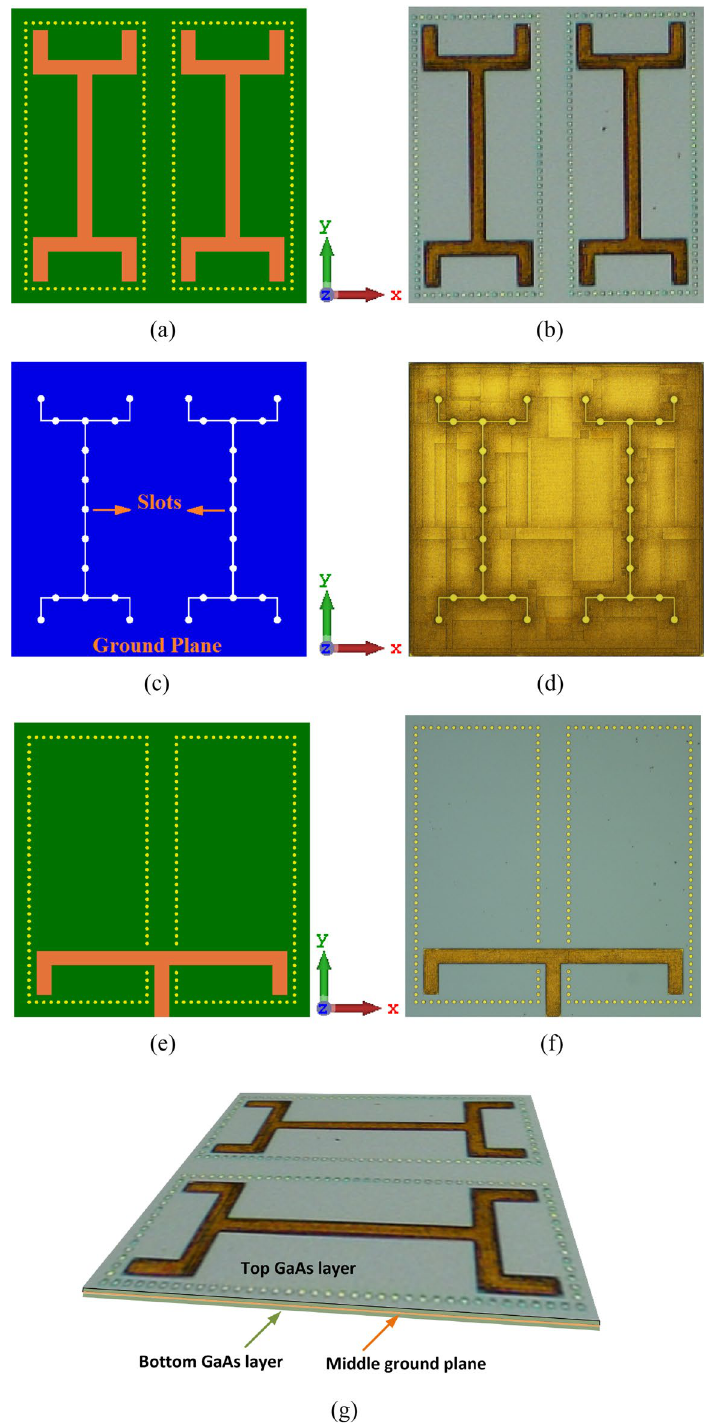
Figure 1. Layout of the SIW inspired on-chip antenna, ( a ) simulated configuration and ( b ) fabricated prototype of the GaAs antenna showing the top surface of the top GaAs layer; ( c ) simulated layout and ( d ) fabricated prototype of the middle metallic ground-plane with circular and linear slots. This layer is sandwiched between the top ( b ) and bottom ( f ) GaAs layers; ( e ) simulated configuration; ( f ) fabricated prototype of the GaAs antenna showing the bottom surface of the bottom GaAs layer; and ( g ) isometric view of the on-chip